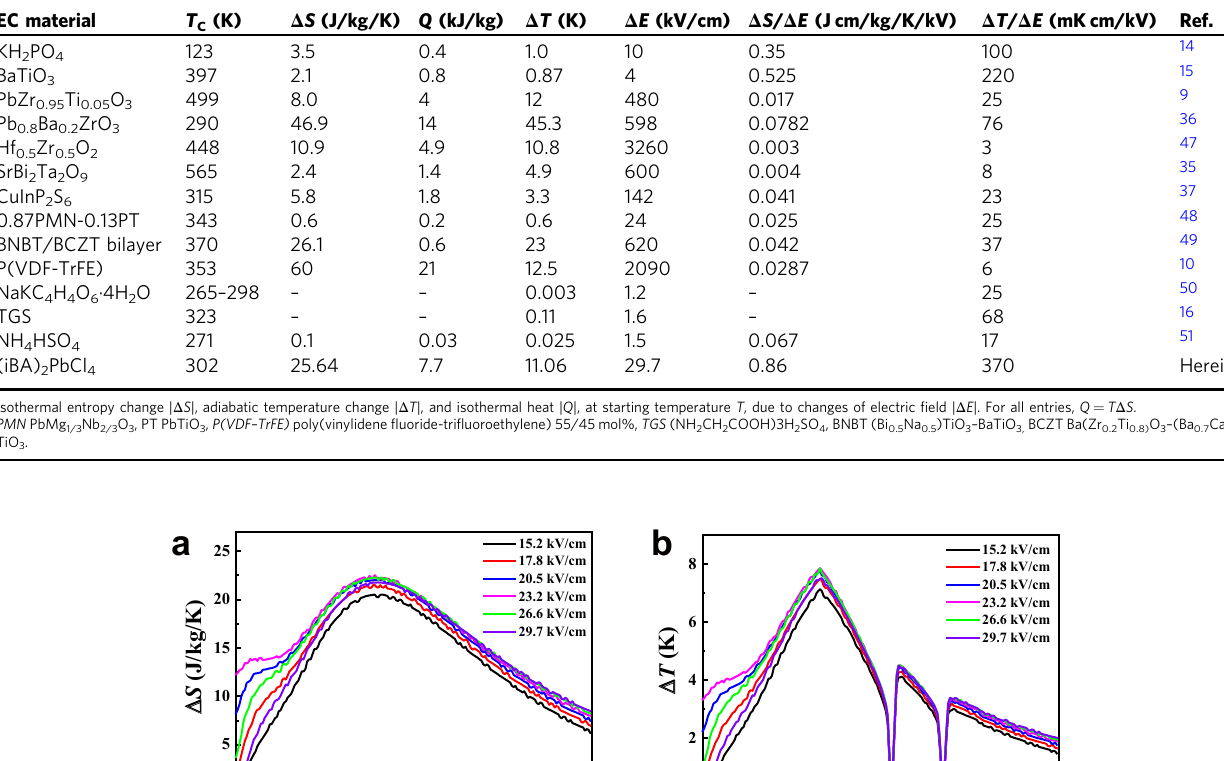
Table 1 Selected electrocaloric effects at phase transitions near and away from room temperature.